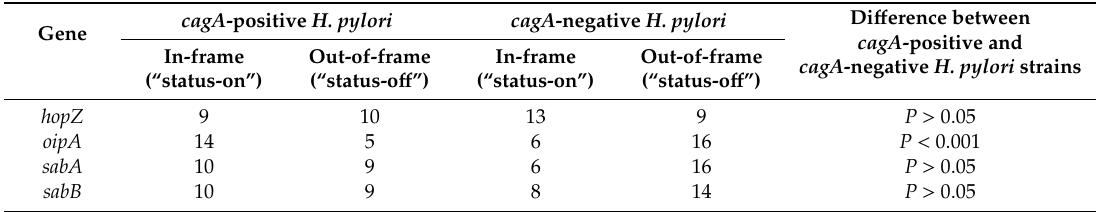
Table 2. Analysis of outer membrane protein encoding genes and their phase variations in 41 H. pylori strains isolated from patients with non-atrophic gastritis.